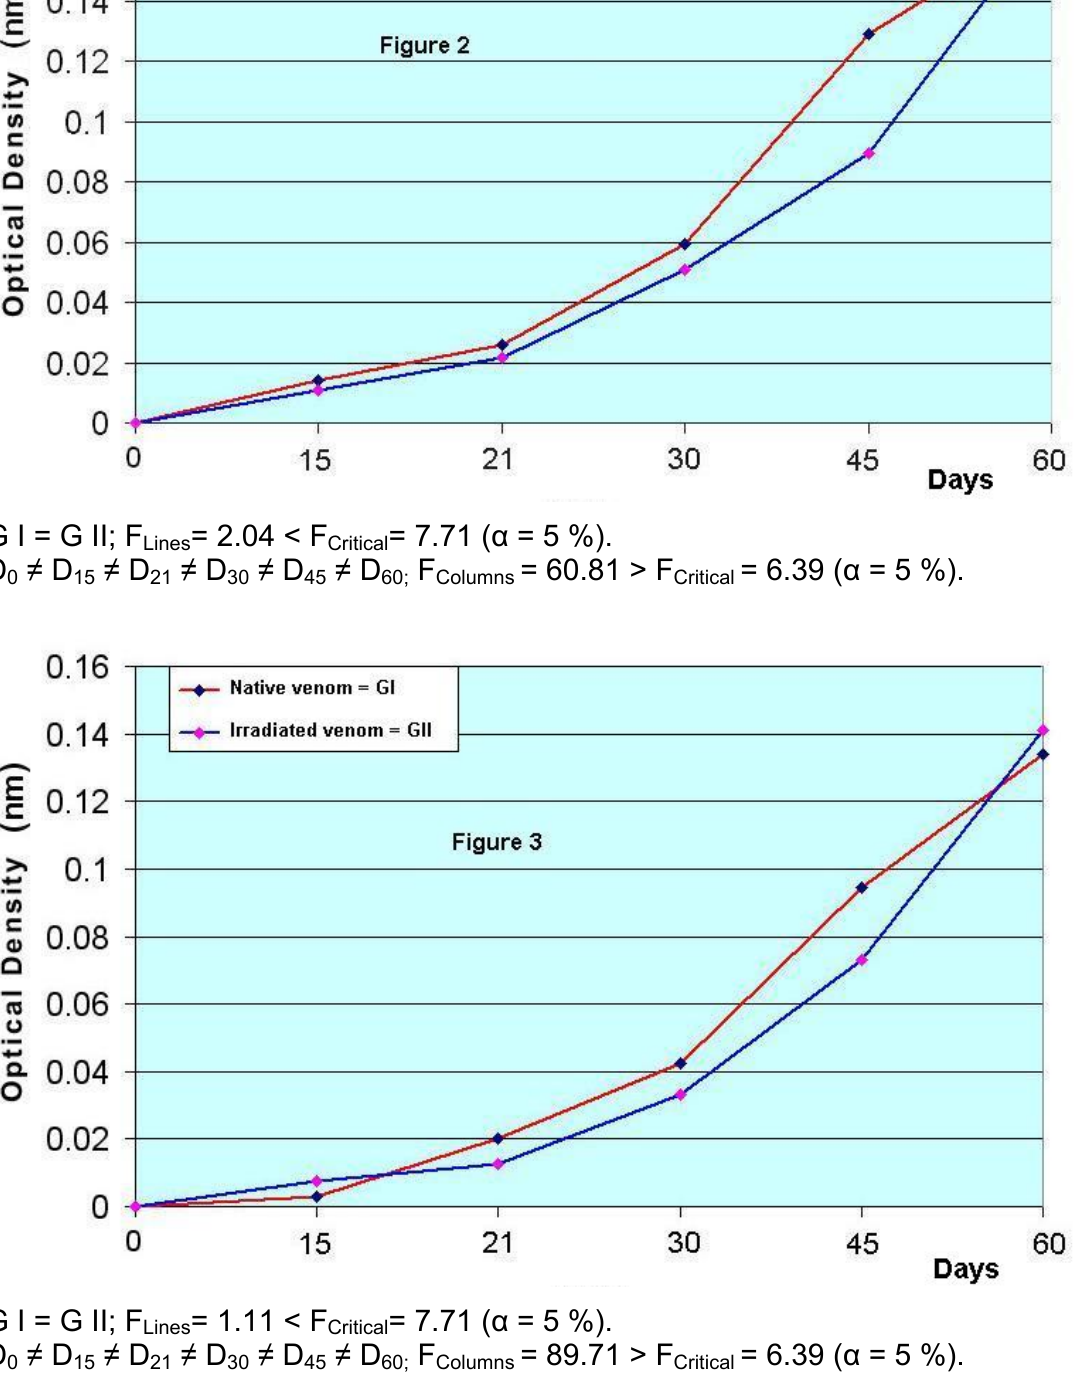
G I = G II; F = 1.11 < F = 7.71 ( α = 5 %). Lines Critical D ≠ D ≠ D ≠ D ≠ D ≠ D F = 89.71 > F = 6.39 ( α = 5 %). 0 15 21 30 45 60; Columns Critical Figures 2 and 3: Distribution of the optical densities (nm) mean values in the ELISA test, in different moments, using serum extracted from animals inoculated with native (GI) and cobalt 60-irradiated (GII) venom, diluted in 1:400 and 1:800